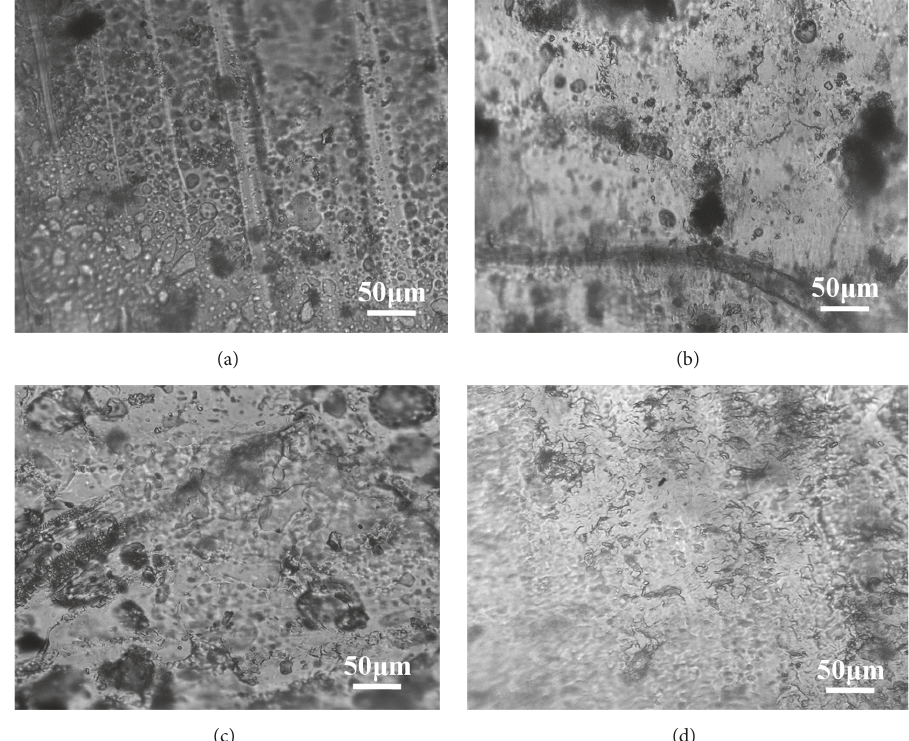
Figure 9: Micrographs of the surfaces ( × 50) of stressed specimens: (a) SWD2 after 60 WD cycles; (b) SWD2 after 180WD cycles; (c) WWD2 after 180 WD cycles; and (d) SWD4 after 180WD cycles.